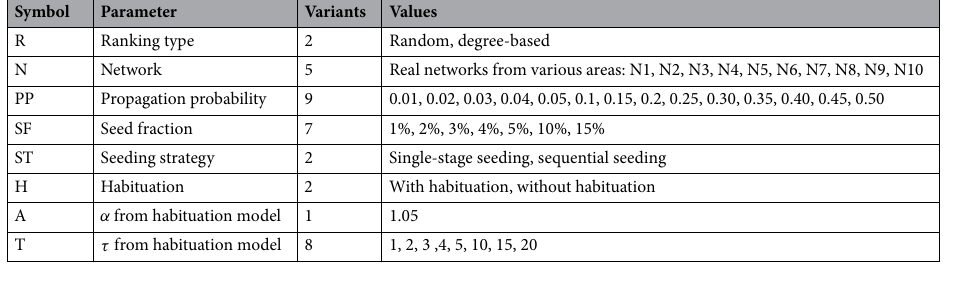
Table 2. Diffusion parameters used in simulations.